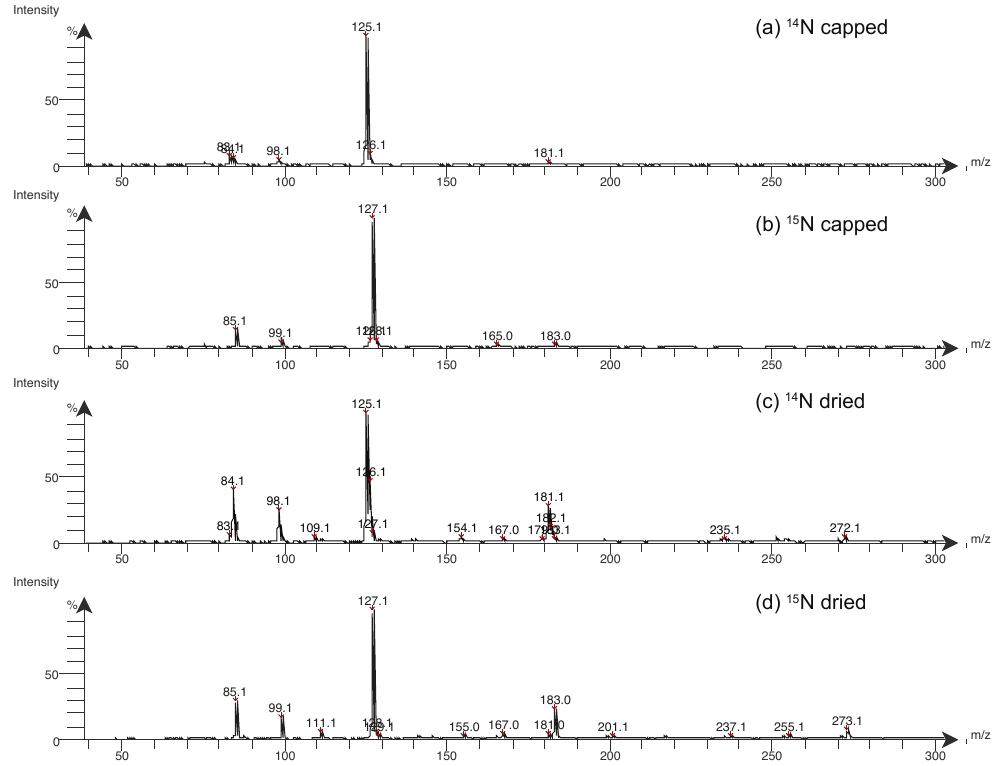
Figure 2. Atmospheric pressure chemical ionization (APCI) mass spectra for all four reactions (after 7 days) between 1.0M methylglyoxal and 1.0M ammonium sulfate (pH2) including those with and without isotopically labeled N. Intensity is set to 100% for the largest signal and does not correspond to concentration in the sample itself.